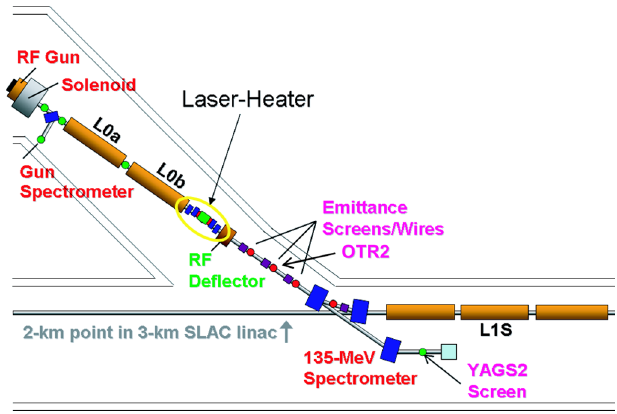
FIG. 1. (Color) The LCLS injector layout showing laser heater, transverse rf deflector, OTR/YAG screens, wire scanners, and